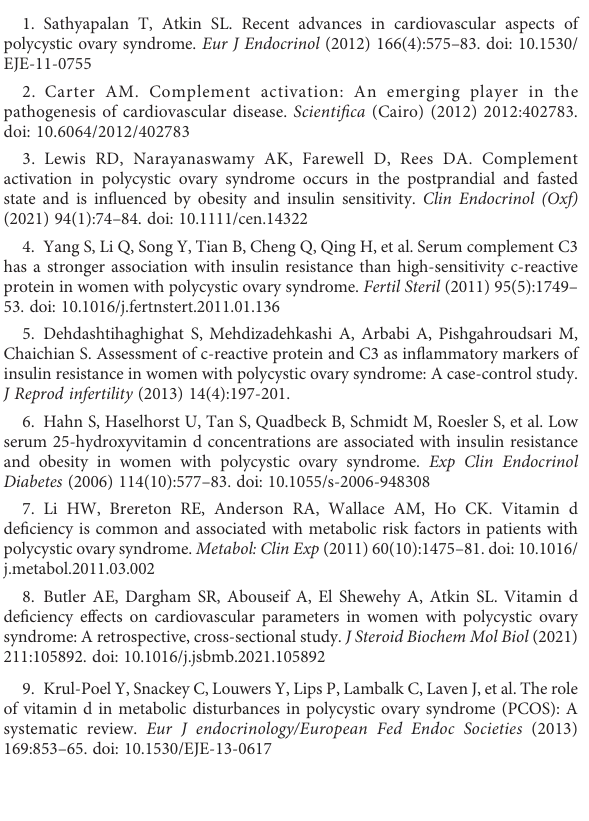
SUPPLEMENTARY FIGURE 1 Correlations of complement pathway proteins with 1,25-dihydroxy vitamin D 3 [1,25(OH) 2 D 3 ]. No correlation of 1,25(OH) 2 D 3 was seen with properdin (A) , iC3b (B) , C3 (C) , C3b (D) or C4 (E) in women with PCOS or control women. Relative Fluorescent Units